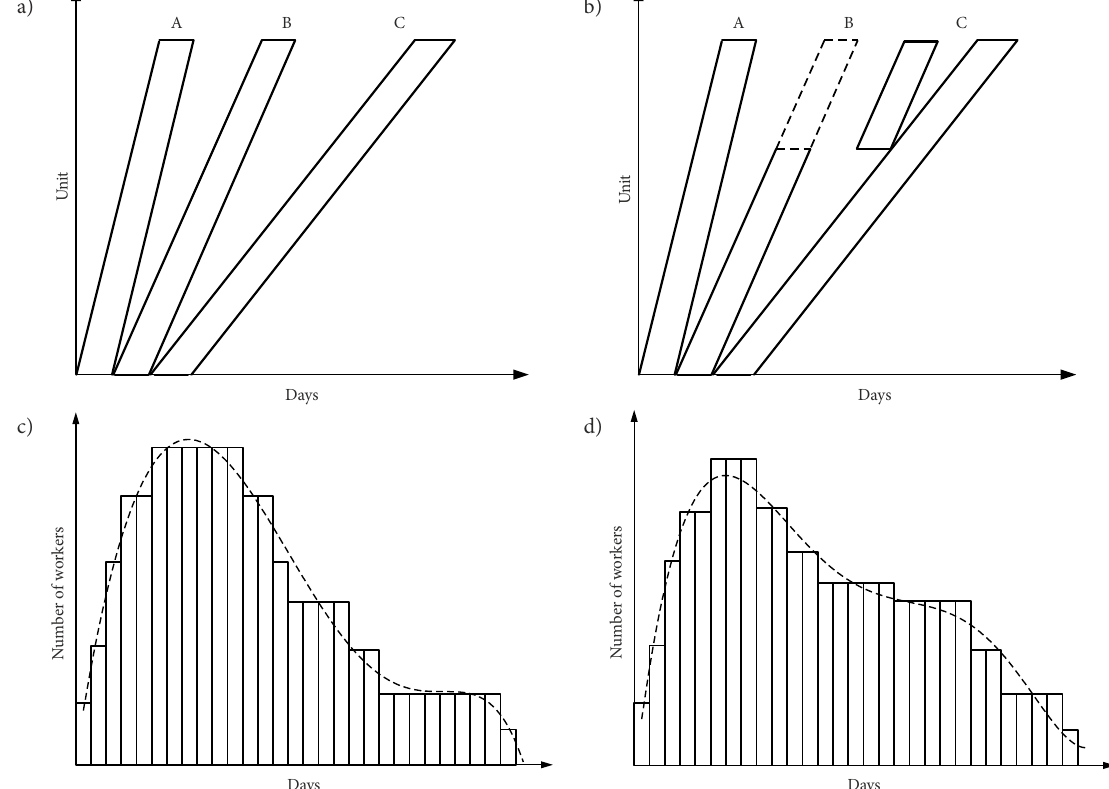
Figure 6. The second case: a – initial LOB schedule; b – LOB schedule with an interruption; c – resource usage curve of the initial LOB schedule; d – resource usage curve of the LOB schedule with an